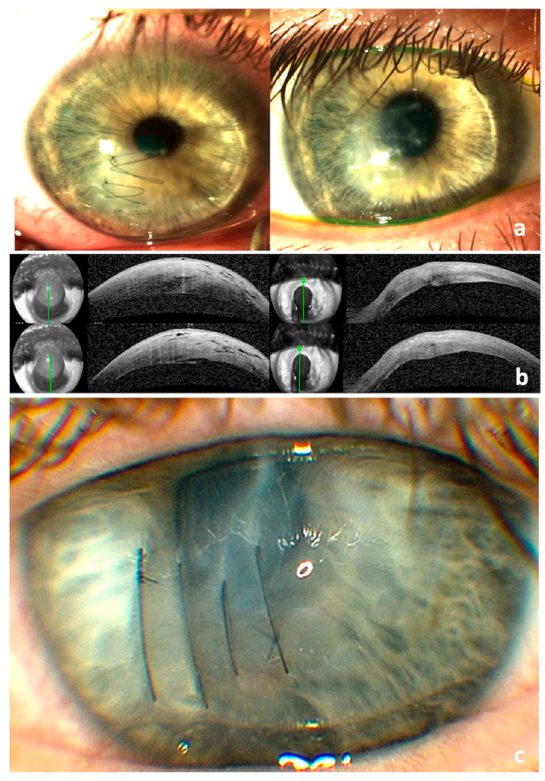
Figure 5. a . Anterior segment photo of the right eye 4 weeks post-suturing ( left ) and after suture removal ( right ); b . Anterior segment OCT: pre-op ( left ) with apex pachymetry of 1024 µ and 14 removal ( right ); ( b ) Anterior segment OCT: pre-op ( left ) with apex pachymetry of 1024 µ and 14 days days post-op ( right ) with apex pachymetry of 493 µ; c . Anterior segment photo of left eye post- post-op ( right ) with apex pachymetry of 493 µ ; ( c ). Anterior segment photo of left eye suturing.